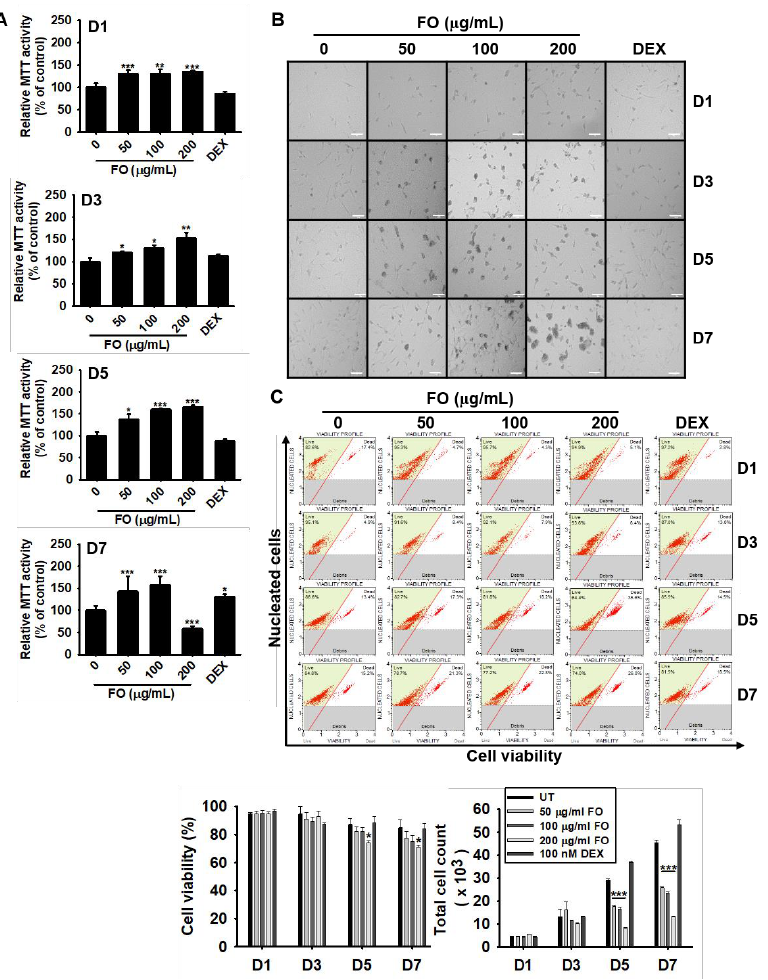
Figure 1. FO increases mitochondrial activity in preosteoblast MC3T3-E1 cells and decreases total cell number. MC3T3-E1 cells were treated with FO (0–200 µg/mL) or 100 nM DEX for 7 days. ( A ) Mitochondrial activity was measured on day 1 (D1), day 3 (D3), day 5 (D5), and day 7 (D7), and ( B ) cell images were collected by Ezscope i900PH phase contrast microscope ( 10). Scale bar shows 100 μm. ( C ) Under the same experimental conditions, cell viability and total cell count were measured using flow cytometric analysis. Significant differences among the groups were determined using the one-way ANOVA followed by Bonferroni correction. All data are presented as mean ± SEM (*** p < 0.001, ** p < 0.01, and * p < 0.05 versus untreated group). FO; fermented extract of C. gigas . DEX; dexamethasone, and UT; untreated control.